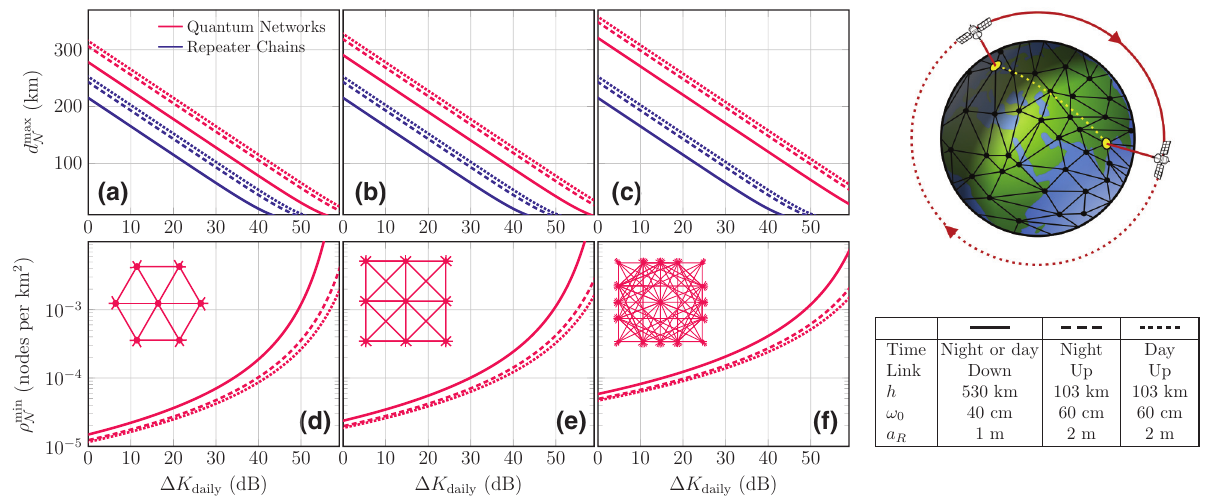
FIG. 3. The daily secret-key-rate advantage (cid:11) K daily in Eq. (25) achieved by fiber-based quantum WRNs and repeater chains with capacity-achieving links over a single sun-synchronous satellite-based repeater operating at practical achievable rates from Eqs. (21) and (22). The architecture of each WRN is shown in the insets to (d)–(f), such that vertically aligned panels use the same architecture. (a)–(c) Plots of (cid:11) K daily with respect to the maximum fiber length permitted within each structure, d max N . (d)–(f) Plots of the relationship between the daily rate advantage (cid:11) K daily and the minimum nodal density required in each WRN to achieve it. Satellite-based advantage can be achieved when (cid:11) K daily ≤ 0. All considered satellite setup parameters are shown in the legend describing the operation time, direction, altitude h , spot size ω 0 , and receiver aperture a R